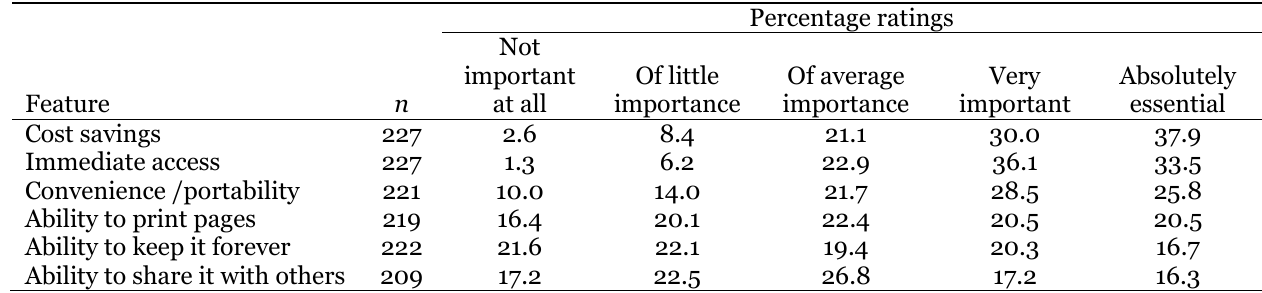
Table 2 Respondents’ Ratings of the Importance of the Features of their Open Textbook